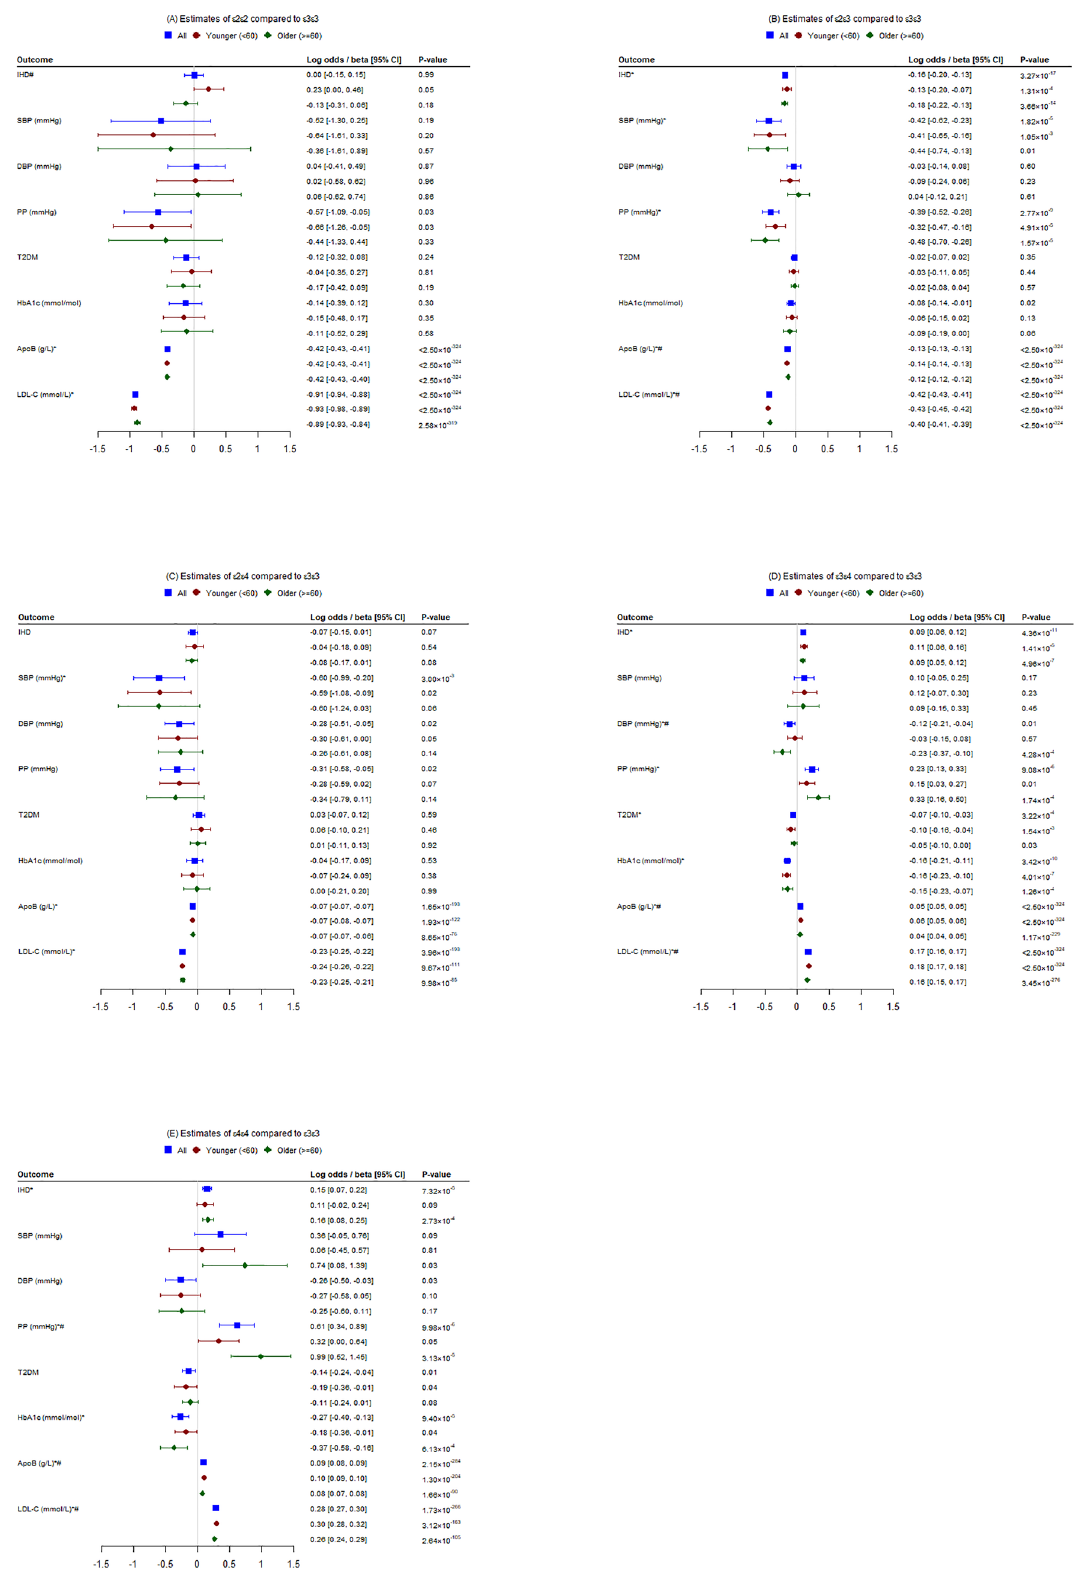
Figure 1. Associations of common APOE genotypes (ε2ε2, ε2ε3, ε2ε4, ε3ε4 and ε4ε4) with ischemic heart disease (IHD) and its risk factors [systolic blood pressure (SBP), diastolic blood pressure (DBP), pulse pressure (PP), type 2 diabetes (T2DM), glycated hemoglobin (HbA1c), plasma apolipoprotein B (apoB), and low-density lipoprotein cholesterol (LDL-C)] compared to ε3ε3 genotype overall and by age group in the UK Biobank (* P value < 0.007, # P value from z tests comparing differences by age group <